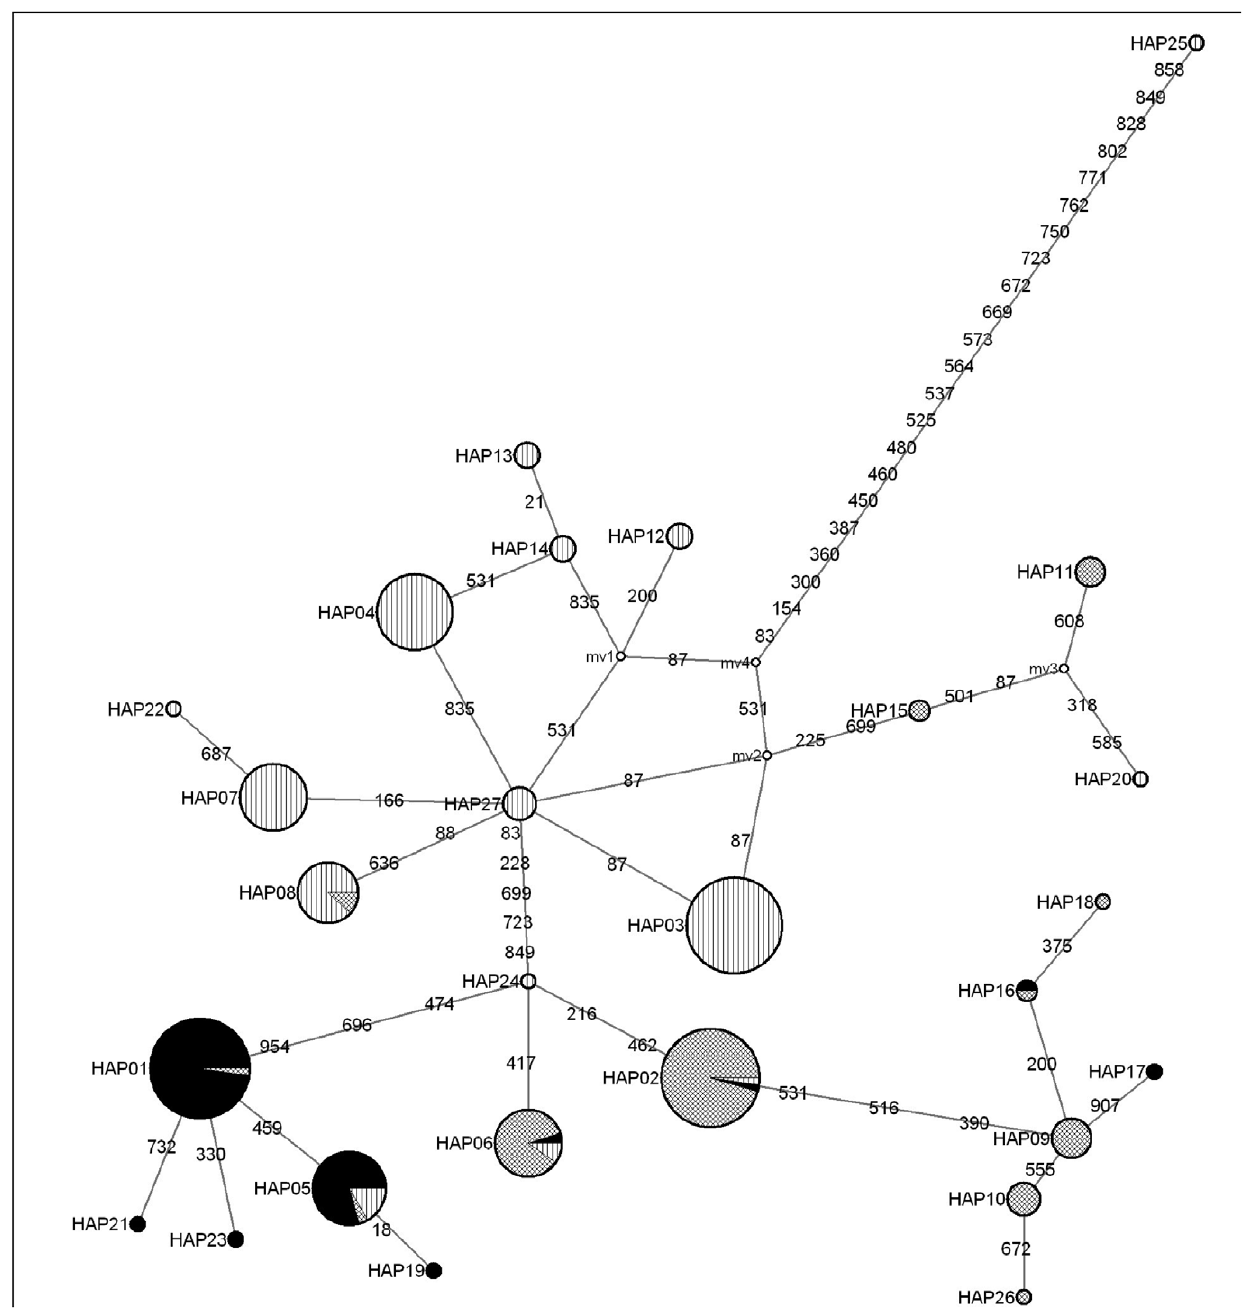
Figure 3. Haplotype network diagram inferred from mtDNA ND5 gene. Solid pattern represents populations assigned to clade I (northwest Peninsular), diagonal cross pattern to clade II (central west Peninsular and Malaysian Borneo except SW) and vertical pattern to clade III (east Peninsular, southern Peninsular, Sumatra and SW). mv=median vector. Numbers in bold are nucleotide mutation sites.